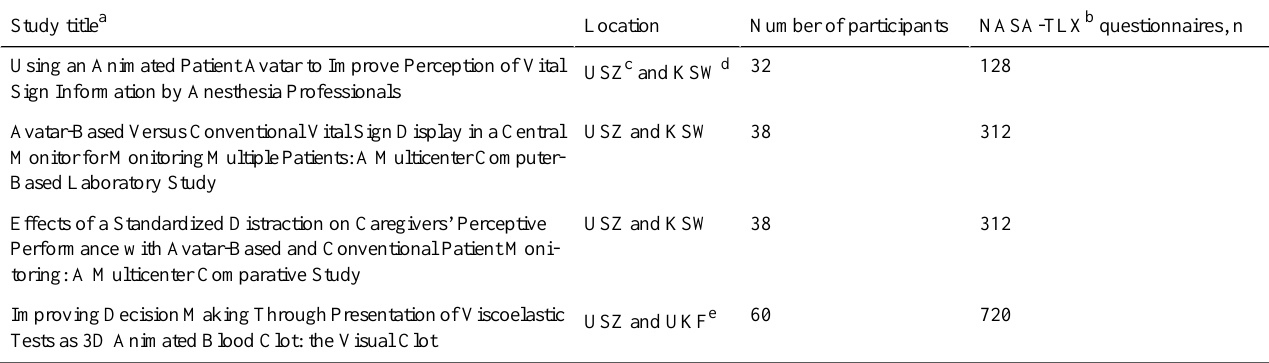
Table 1. Description of the four studies used with the respective participant numbers and completed National Aeronautics and Space Administration Task Load Index questionnaires.